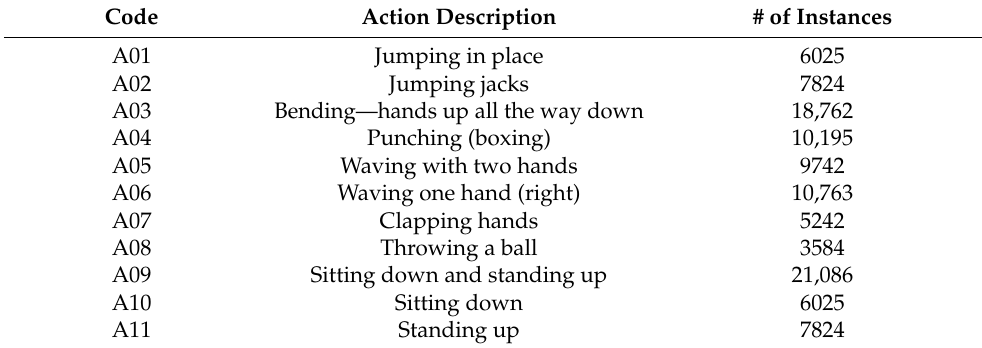
Table 2. Activity list.